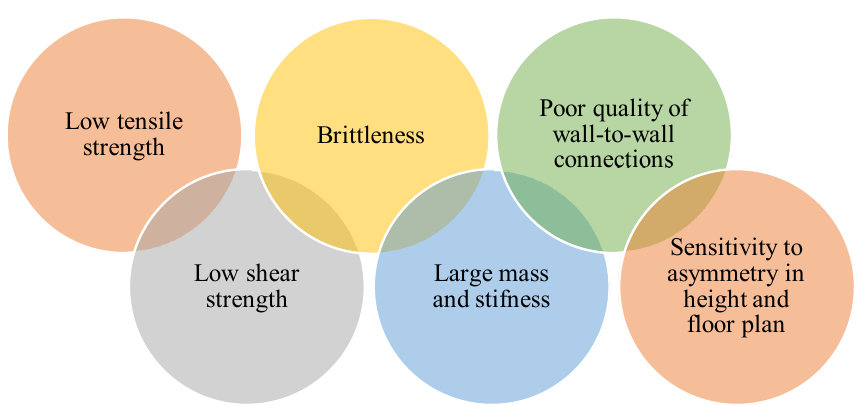
Figure 5. Typical characteristics of unreinforced masonry structures in Croatia.